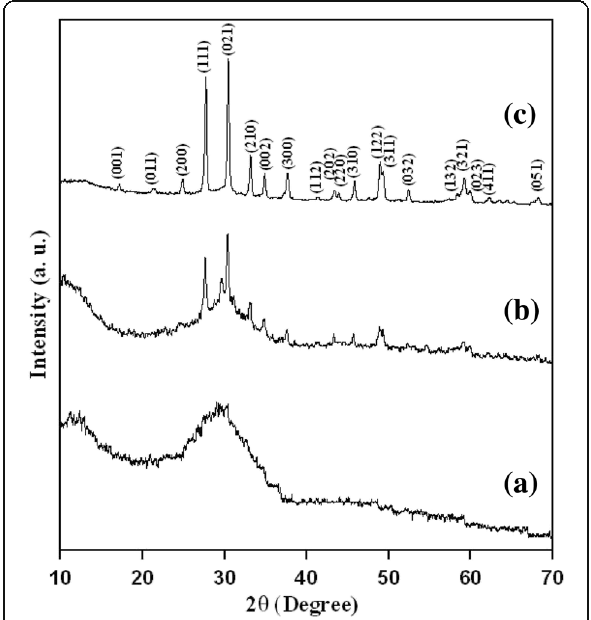
Fig. 1 X-ray diffraction patterns of La 3 Ga 5.5 Nb 0.5 O 14 precursor powders annealed at ( a ) 600, ( b ) 700, and ( c ) 800°C for 3